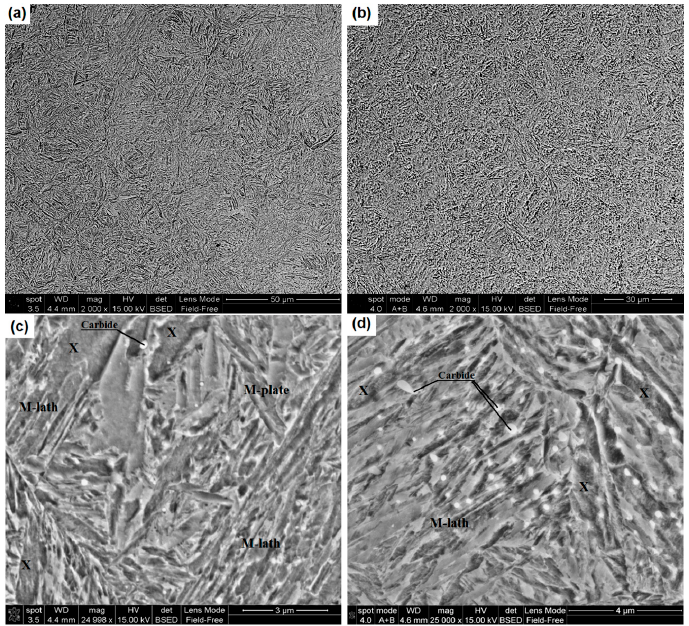
Figure 3. Field emission gun scanning electron microscopy (FEG-SEM) images of ( a , c ) the oil-quenched sample and ( b , d ) the 5 min austempered sample.